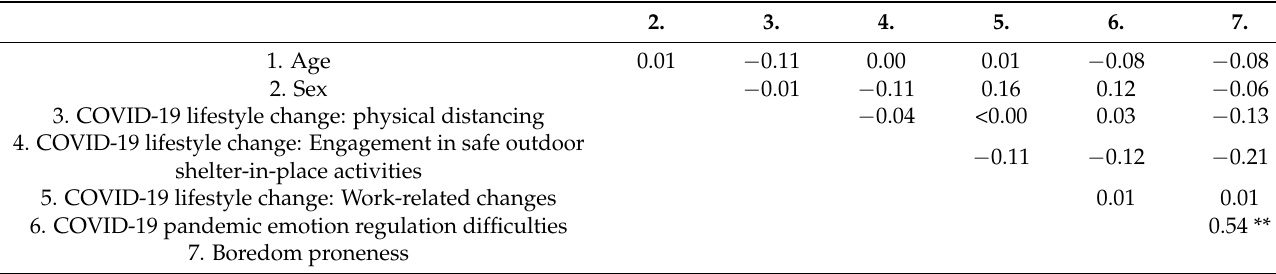
Table 2. Correlations Matrix for all study variables.